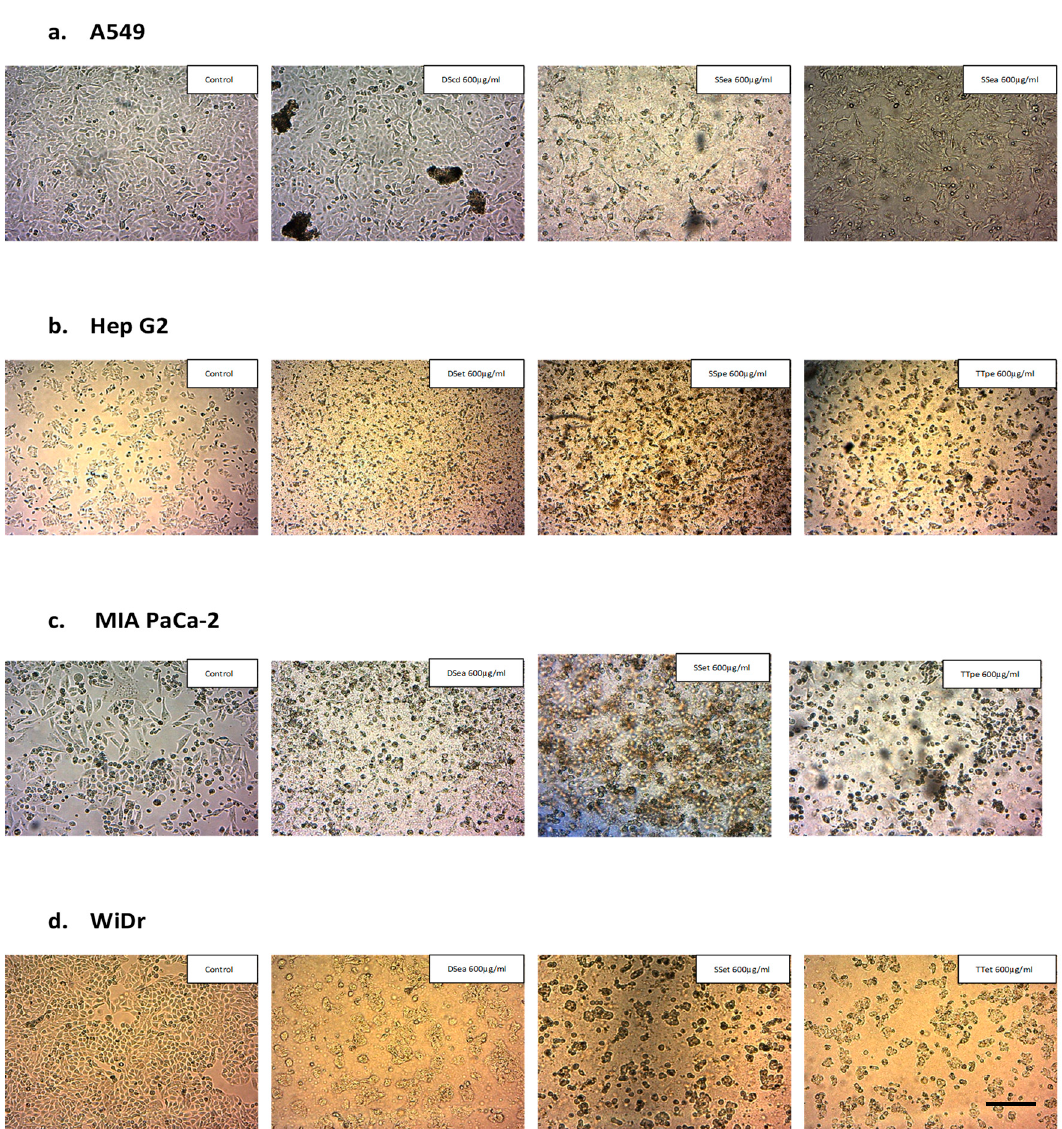
Figure 2. Morphological examination of extract-treated cancer cell lines, A549 ( a ), Hep G2 ( b ), MIA PaCa-2 ( c ), and WiDr cells ( d ) (scale bar: 20 µ m)